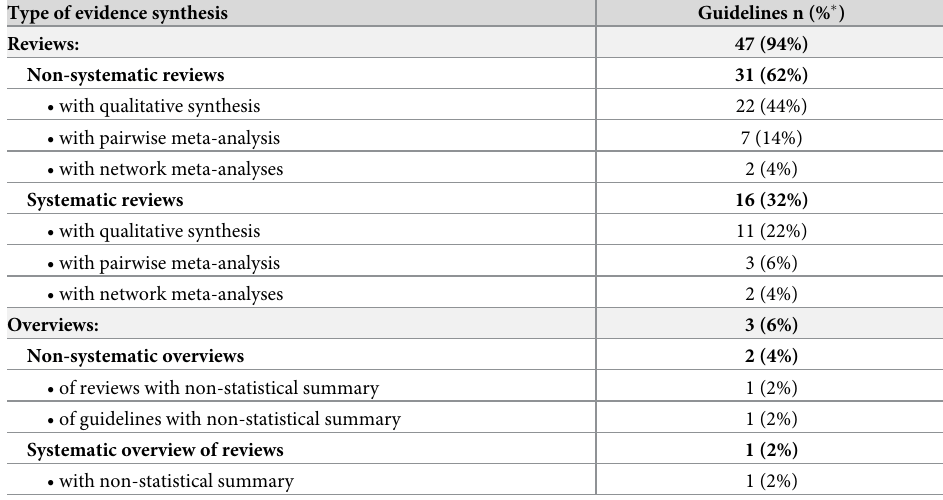
Table 3. Clinical practice guidelines using a systematic or non-systematic approach to evidence syntheses (n = 50).